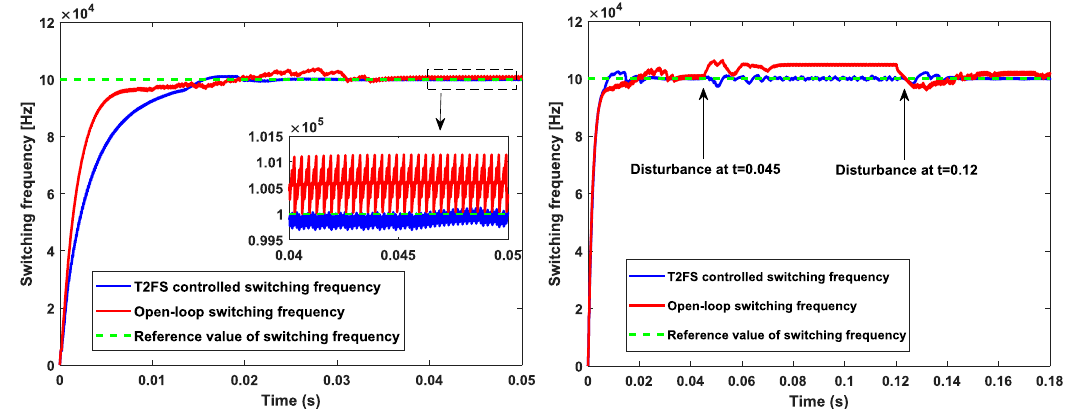
Figure 11. Open-loop and closed-loop control of switching frequency under start-up and input voltage